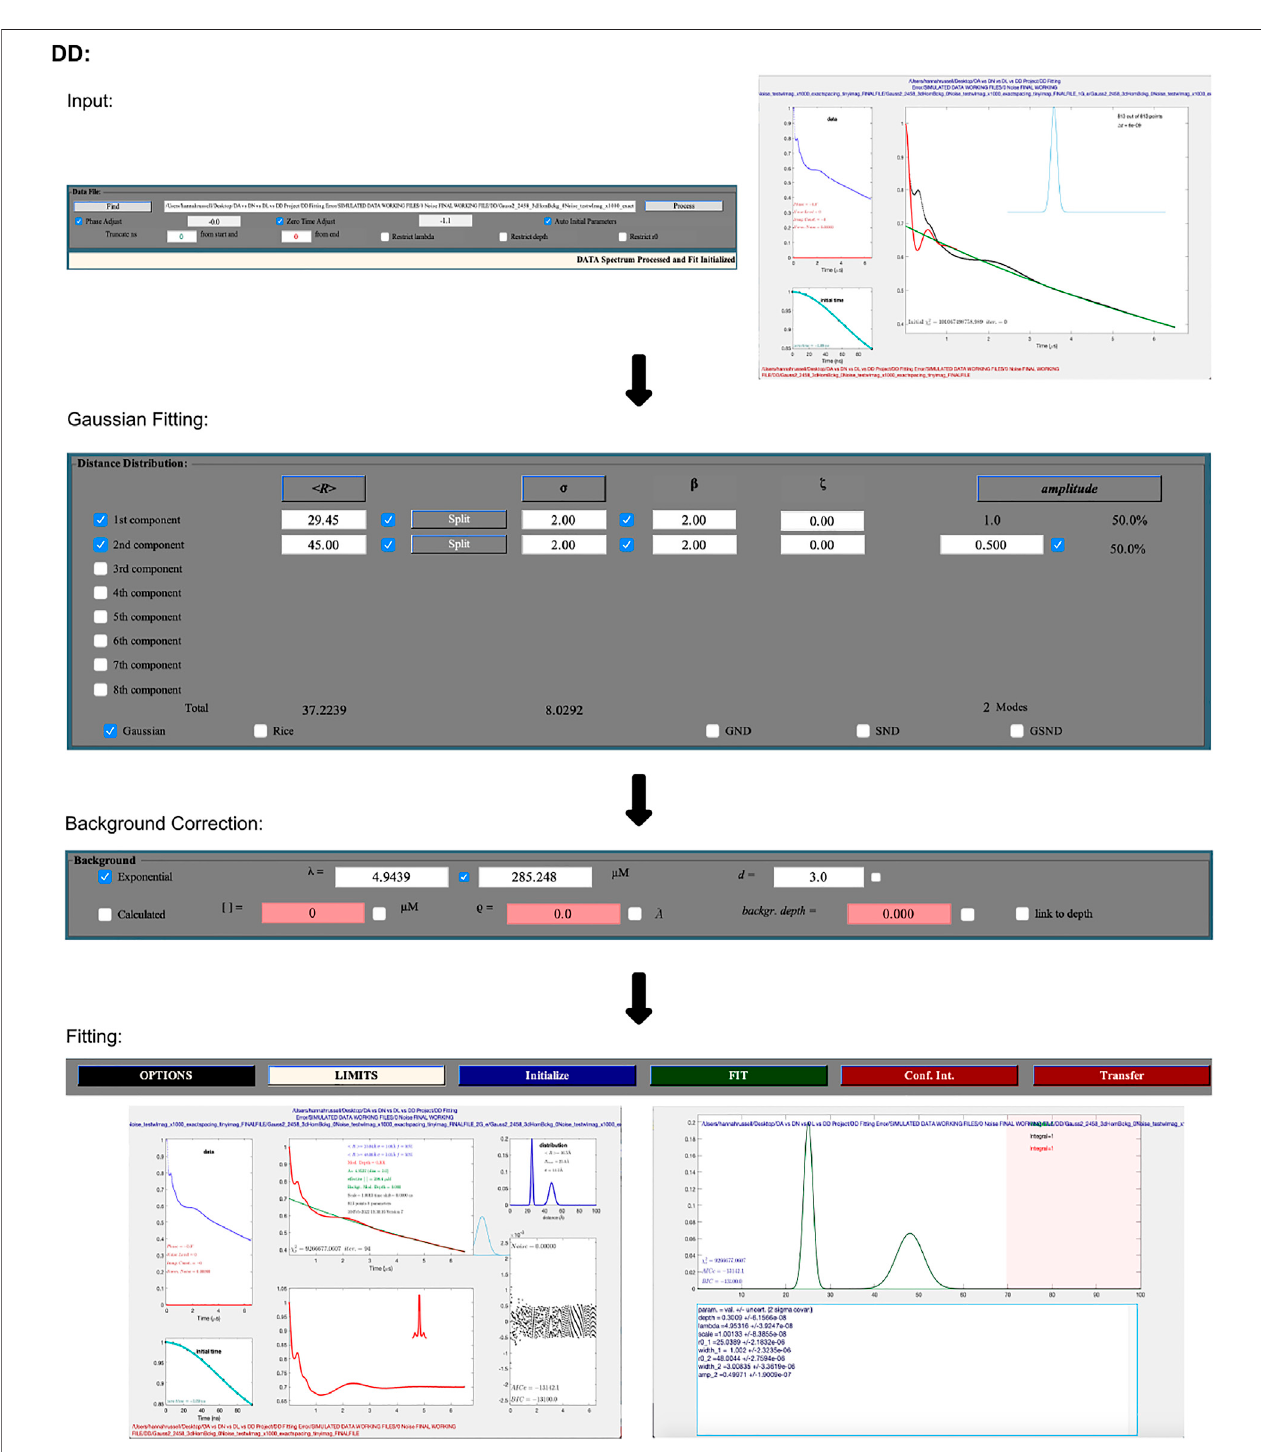
FIGURE4| DDwork fl ow.ThepackageisMatlab-basedandavailableonalloperatingsystems.Datasetshown issimulatednoiseless,whichwasanASCII fi le.No additional steps or changes are required for importing different fi le types.